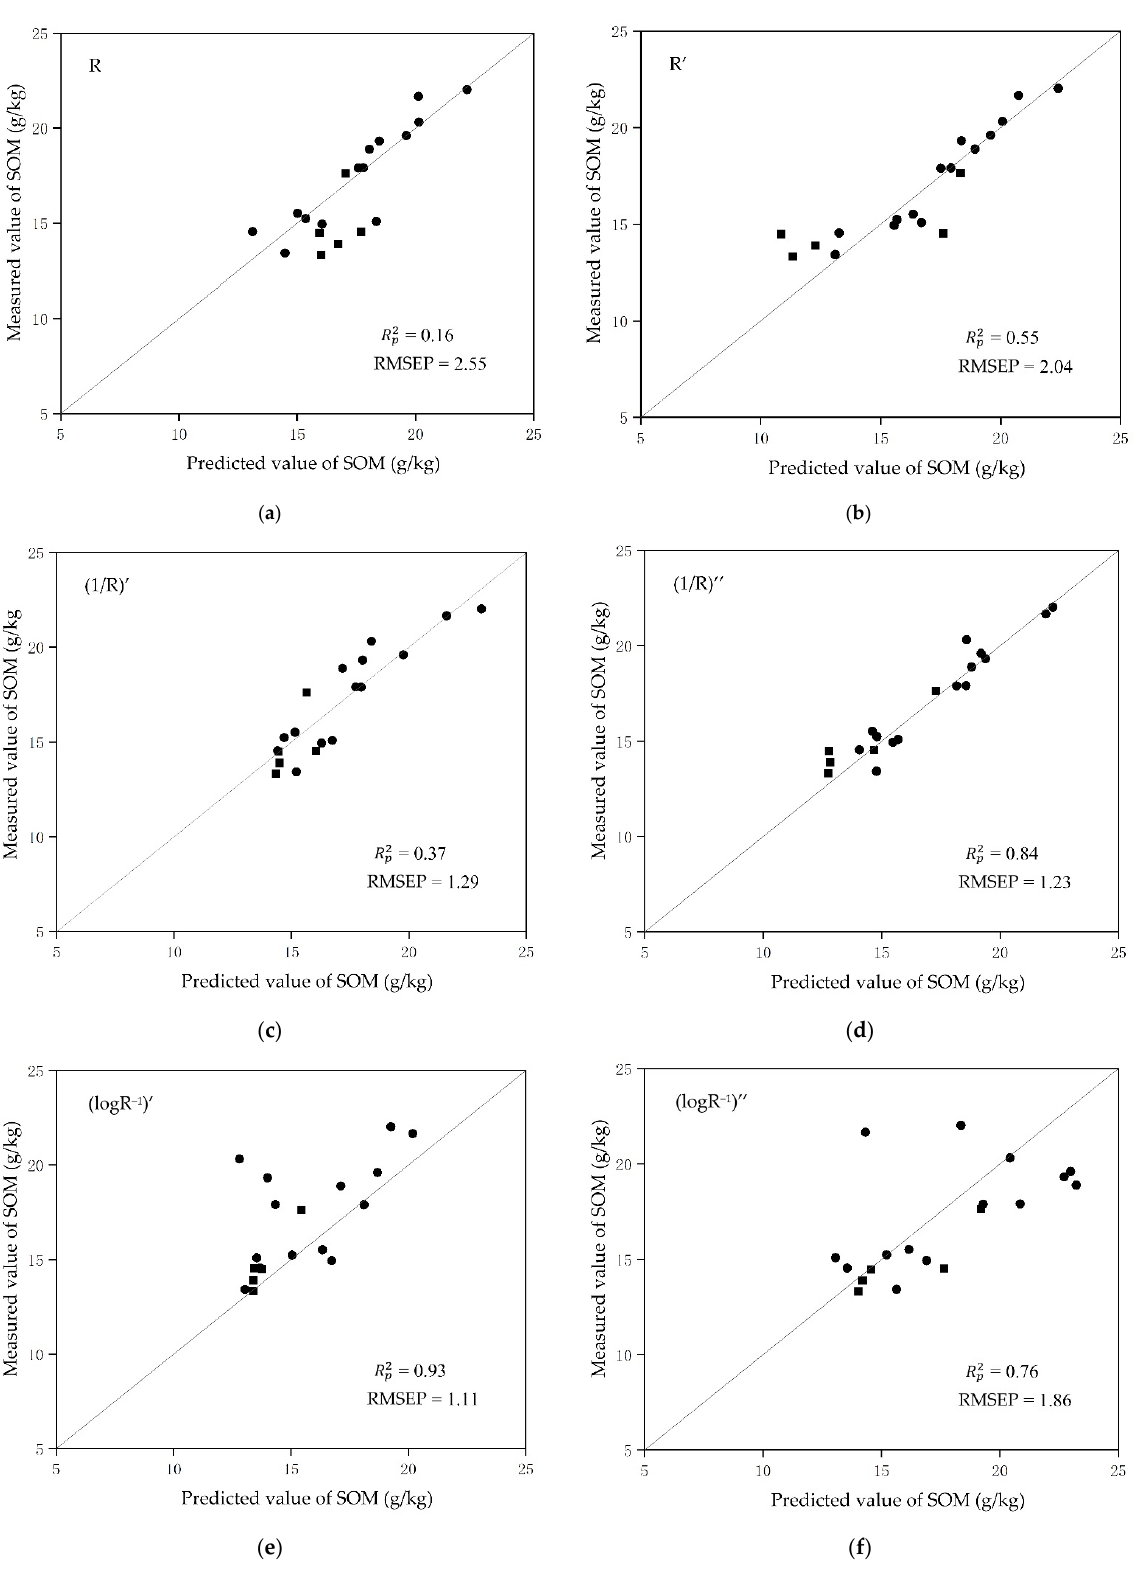
Figure 5. Model validation. ( a ) Original multi-band measured value; ( b ) First derivative of the multi- band measured value; ( c ) First derivative of reciprocal multi-band measured value; ( d ) Second derivative of reciprocal multi-band measured value; ( e ) First derivative of the reciprocal logarithm multi-band measured value; ( f ) Second derivative of the reciprocal logarithm multi-band measured